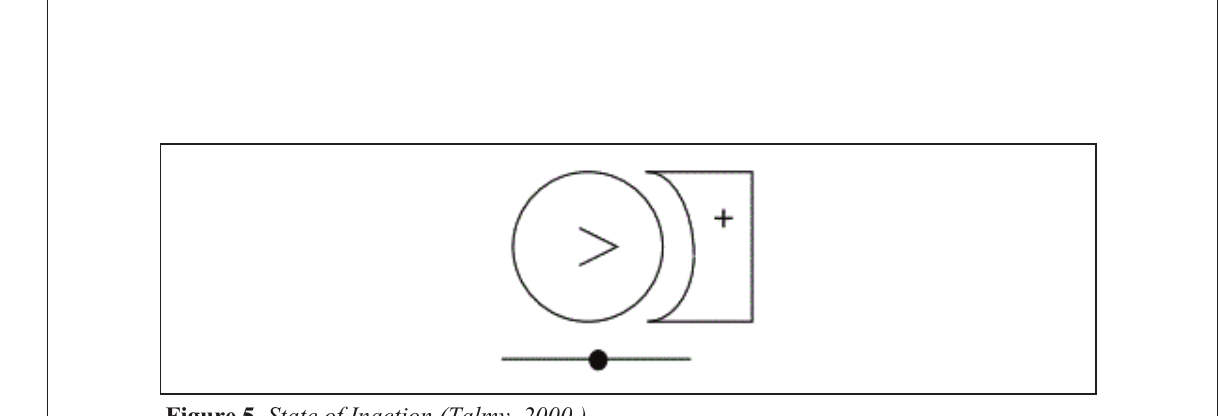
Figure 5. State of Inaction (Talmy, 2000 ).